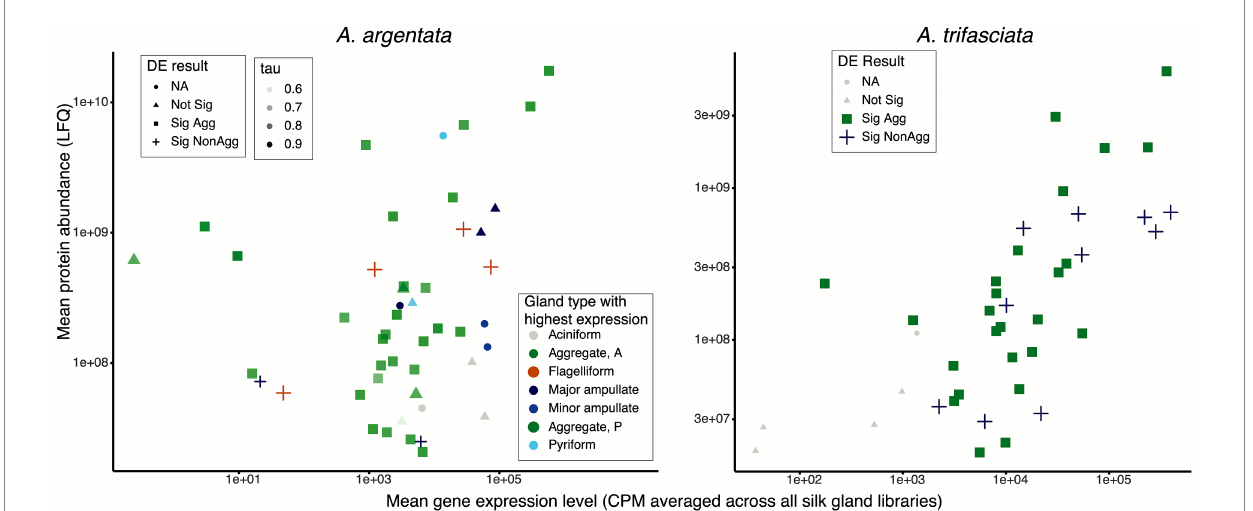
FIGURE 5 Capture spiral protein abundance (LFQ) and their gene expression levels in silk glands (average CPM) for Argiope argentata and A. trifasciata . Capture spirals are a composite of an axial fiber made in flagelliform glands and an aqueous glue synthesized in aggregate glands. Mean expression level (mean Counts Per Million mapped reads, CPM) was determined by DESeq2. DE result indicates outcome of differential expression analyses (Sig Agg = significantly higher expression in aggregate glands; Sig NonAgg = significantly higher expression in non-aggregate silk glands). For A. argentata , the gland type with highest expression is also indicated with all but two proteins found in capture spirals having highly biased expression to a single silk gland type (45 with tau >0.8, Yanai et al., 2005). The green proteins in this figure are likely aggregate glue proteins.